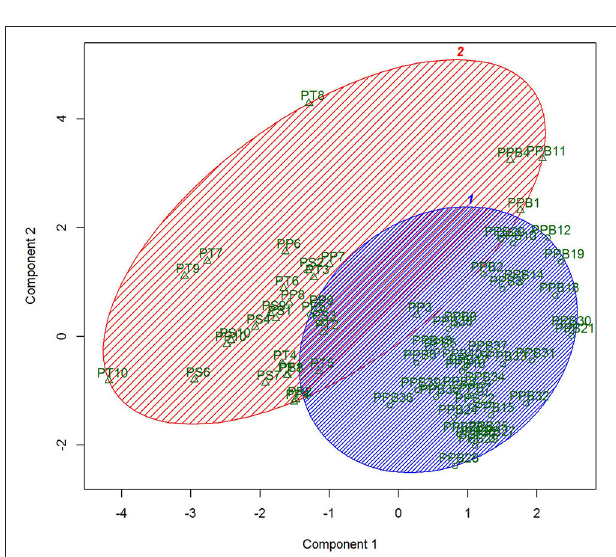
FIGURE 8 | Spermonde reef island sediment samples, k-means cluster results suggesting two clusters. One cluster mainly composed of the samples from P. Panambungan (PPB) and a second cluster mainly composed of the samples from P. Panamgangang (PP), P. Suranti (PS) and P. Tambakulu (PT). The two components explain 62.85% of the point